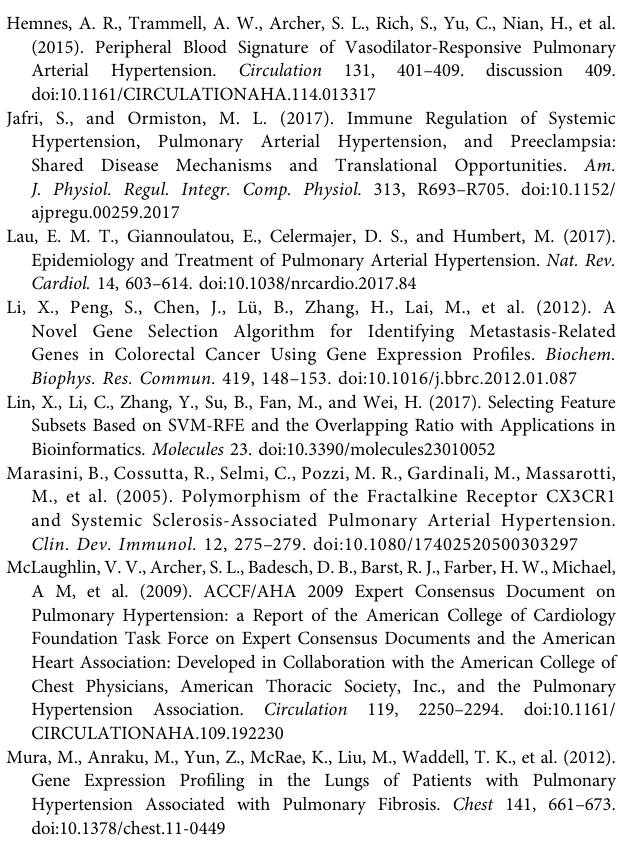
Supplementary Figure S1 | Supplementary Figure of GO and KEGG analyses forof DEGs (A) Bubble plot of GO functional annotation of DEGs. The color of circles denotes statistical signi fi cance. The size of the circles denotes the number of enriched DEGs. X-axis denotes the percentage of the number of enriched DEGs inout of all genes. BP: biological process. CC: cellular component. MF: molecular function; (B) KEGG pathway enrichment analysis of